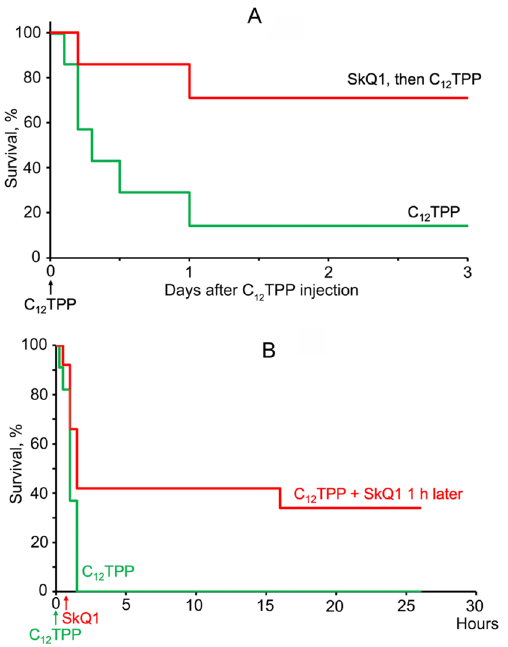
Figure 8. SkQ1 protects mice against toxic doses of C 12 TPP. ( A ) Survival of mice after a single intravenous injection of 34 μmol/kg C 12 TPP. SkQ1 (1.5 μmol/kg/day) was injected as in Fig. 2. The groups contained 7 mice. ( B ) Survival of mice after a single intravenous injection of 42 μmol/kg C 12 TPP. SkQ1 (1.5 μmol/kg) was injected within the first hour after C 12 TPP. Number of mice: 11 with C 12 TPP and 12 with C 12 TPP +